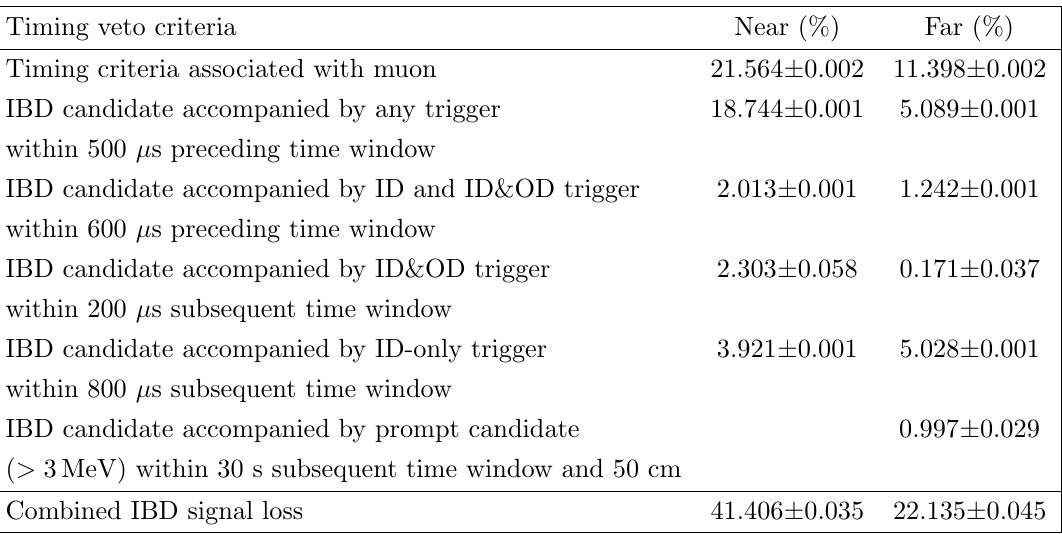
Table 5 . IBD signal loss due to timing veto criteria. The loss is determined by trigger or muon